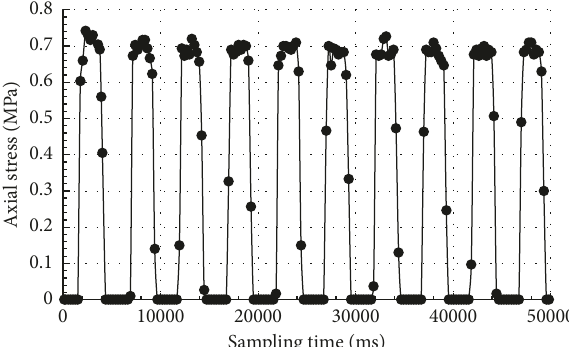
Figure 3: Axial stress curve ( T and A 0.5mm). (cid:31)